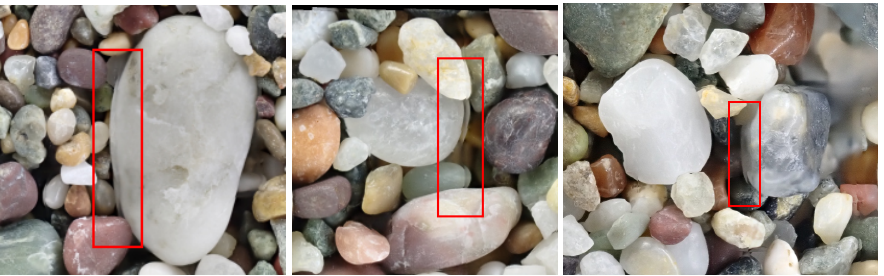
Figure 16. Registration failure examples.